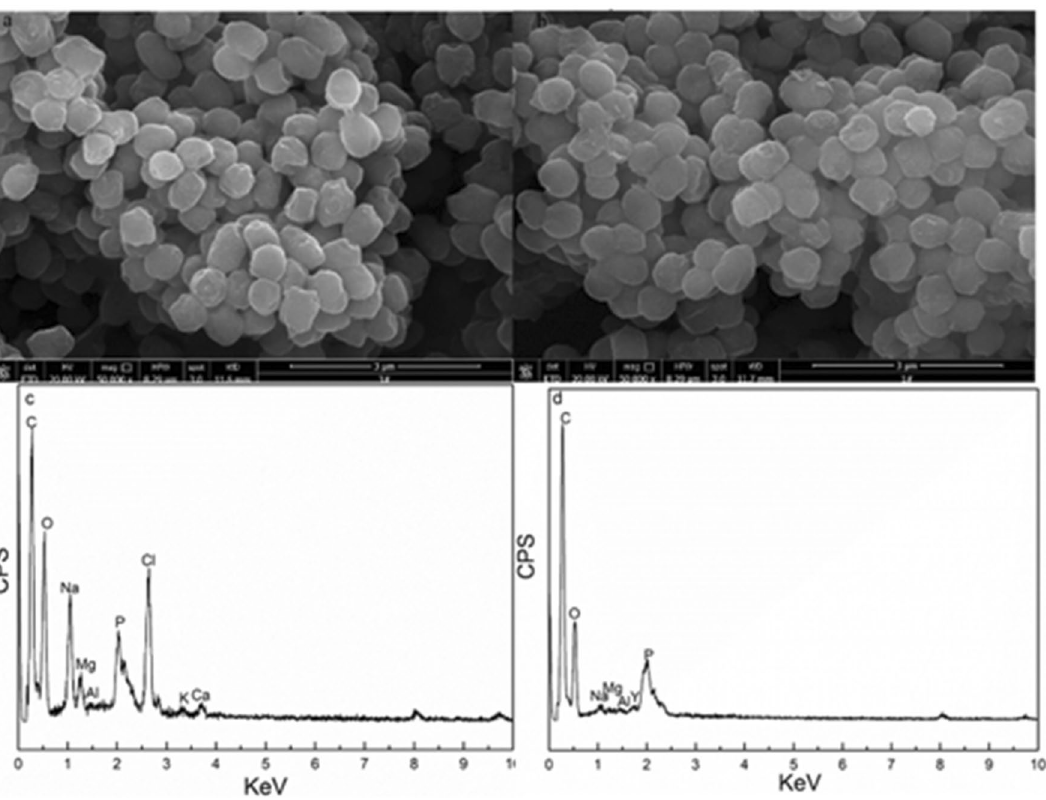
Figure 5. SEM spectra of S. marcescens ( a ) before and ( b ) after Y(III) biosorption, EDS spectra of S. marcescens ( c ) before and ( d ) after Y(III) biosorption. Samples Yttrium